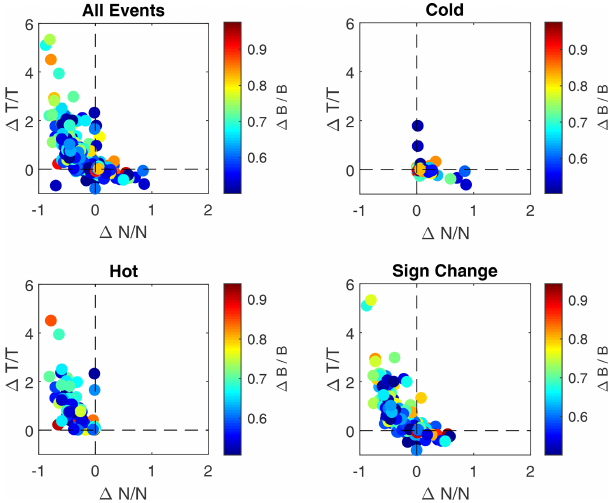
Figure 5. Scatter plot of the (cid:49)T/T vs. (cid:49)N/N for all LMH struc- tures. The colour coding is the (cid:49)B/B of each